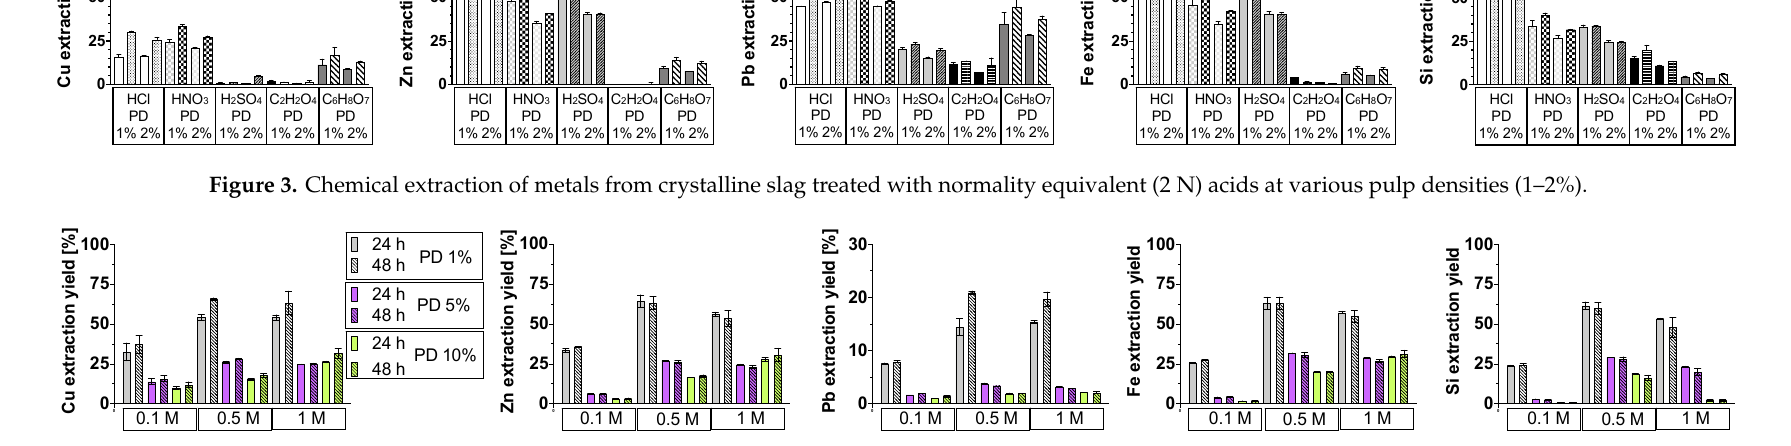
Figure 4. Chemical extraction of metals from amorphous slag treated with sulfuric acid at different concentrations (0.1–1 M) and various pulp densities (1–10%).